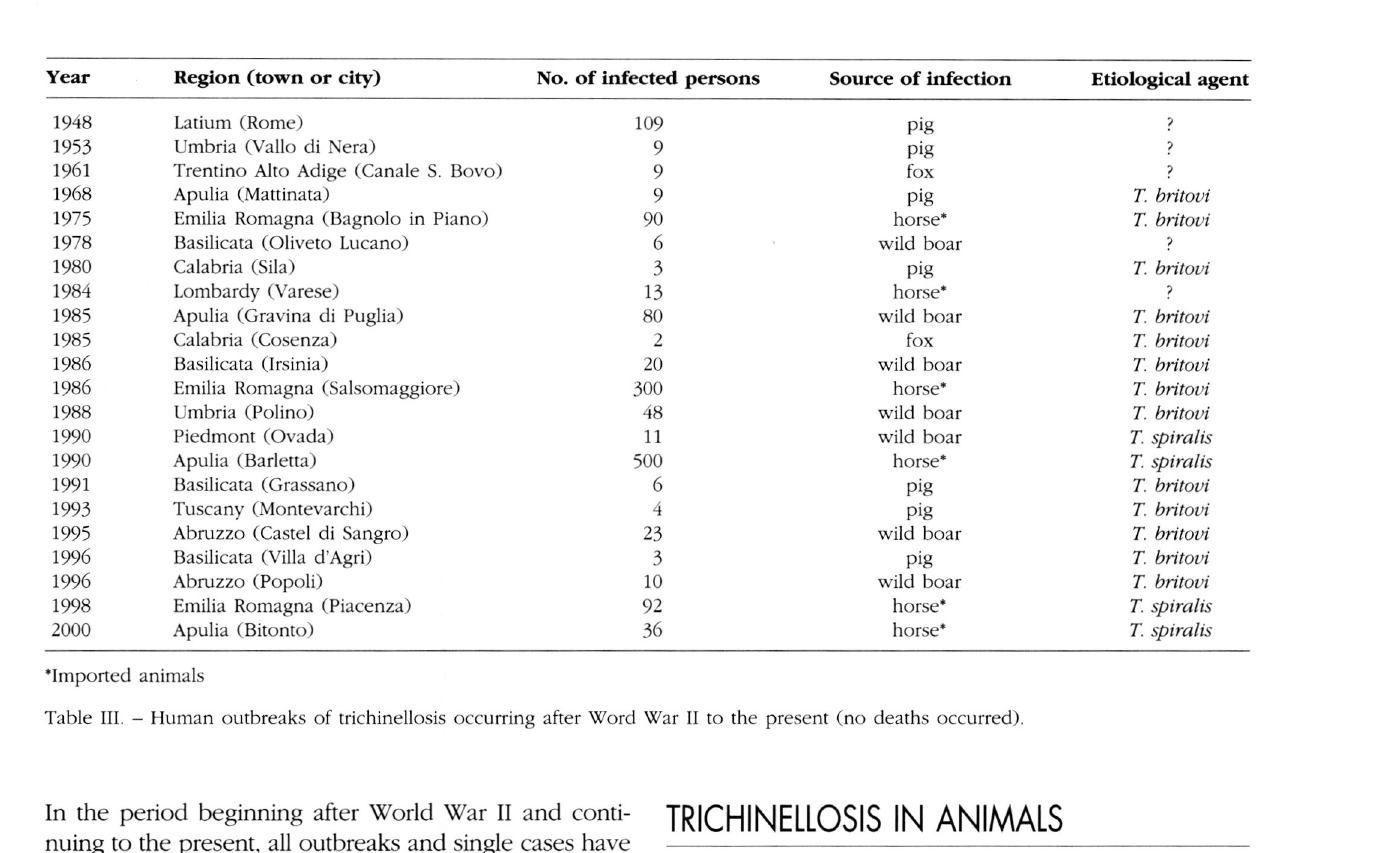
Table III. - Human outbreaks of trichinellosis occurring after Word War II to the present (no deaths occurred).